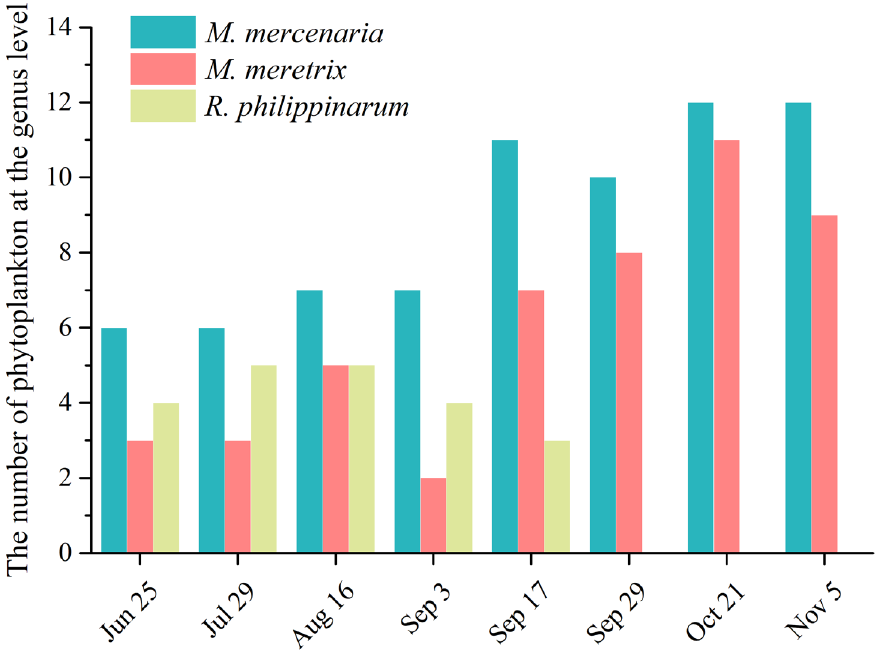
Figure 9. The number of phytoplankton at the genus level selected by M. mercenaria , M. meretrix and R. philippinarum grown in